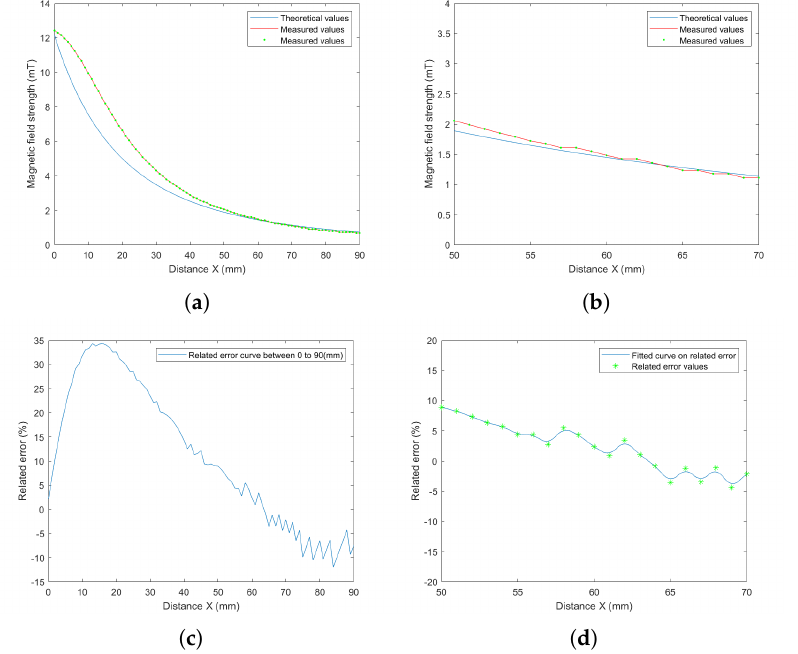
Figure 25. Comparison of theoretical values and measured values of the magnetic field: ( a ) Magnetic field strength along the symmetry axis ( x axis) of the electromagnet, and comparison of theoretical values and measured values. The detected locations were selected to be from 0 to 90 mm for the measurements and ( b ) the detected locations were selected to be from 50 to 70 mm for the measurements. ( c , d ) the relative error within the workspace. The detected locations were selected to be from 0 to 90 mm and from 50 to 70 mm for the measurements. ( a ) Computed values and measured data. ( b ) Computed and measured data in a given small range of distance. ( c ) The relative error within the workspace. ( d ) The relative error within the selected region.